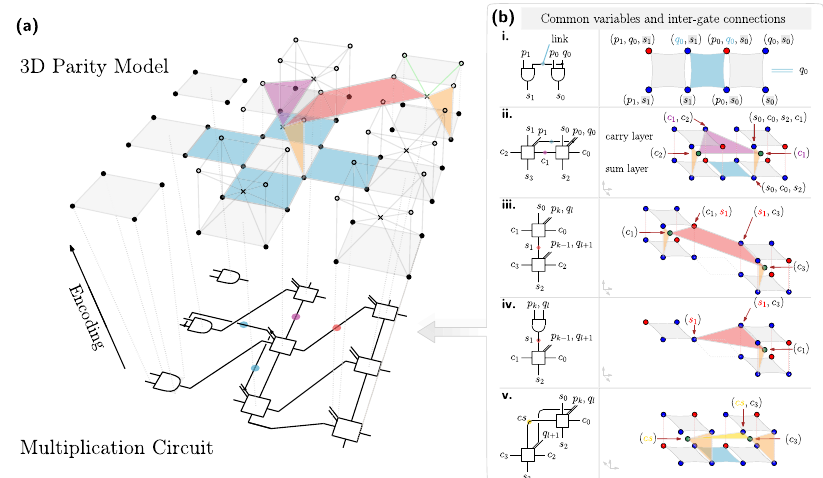
Fig. 4 Blueprint for parity factorization - Three-dimensional layout. a The multiplication circuit is mapped onto an array of physical qubits arranged on three layers of a 3D lattice. Dots and crosses represent qubits on different layers while faces represent constraints [see Supplementary Figure 2 for the labeling of the qubits and Supplementary Fig. 3 for the plot including all constraints]. Beside boundaries, the whole architecture can be constructed from repeating unit cell consisting of nine qubits connected to neighboring cells via additional constraints (blue, red, violet, yellow, orange). For illustrative purposes, only a selected number of qubits and constraints are displayed. b Building instructions. Each connection between logical gates translates into 3-body or 4-body parity constraints (blue, red, violet, yellow). The device is programmable in the sense that a given bi-prime n can be encoded by imposing additional 2-body constraints ( a green). Thus the ground state n ¼ pq j i reveals the factors p and q